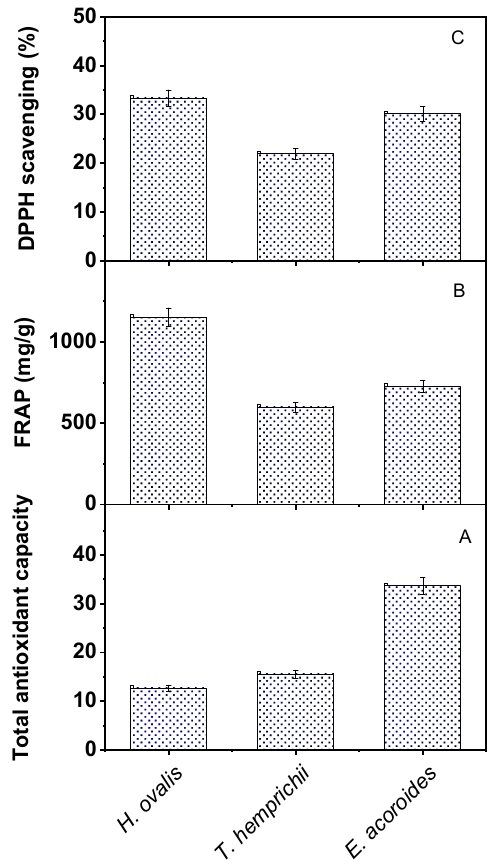
Figure 5. Total antioxidant capacity calculated in milligram of ascorbic acid per gram of pectin sample ( A ), ferric reducing antioxidant power (FRAP) activity ( B ), DPPH radical scavenging activity ( C ) of Vietnamese seagrass pectins.